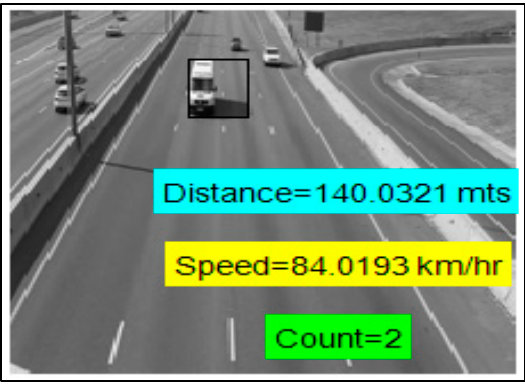
Figure 17. Measured data.